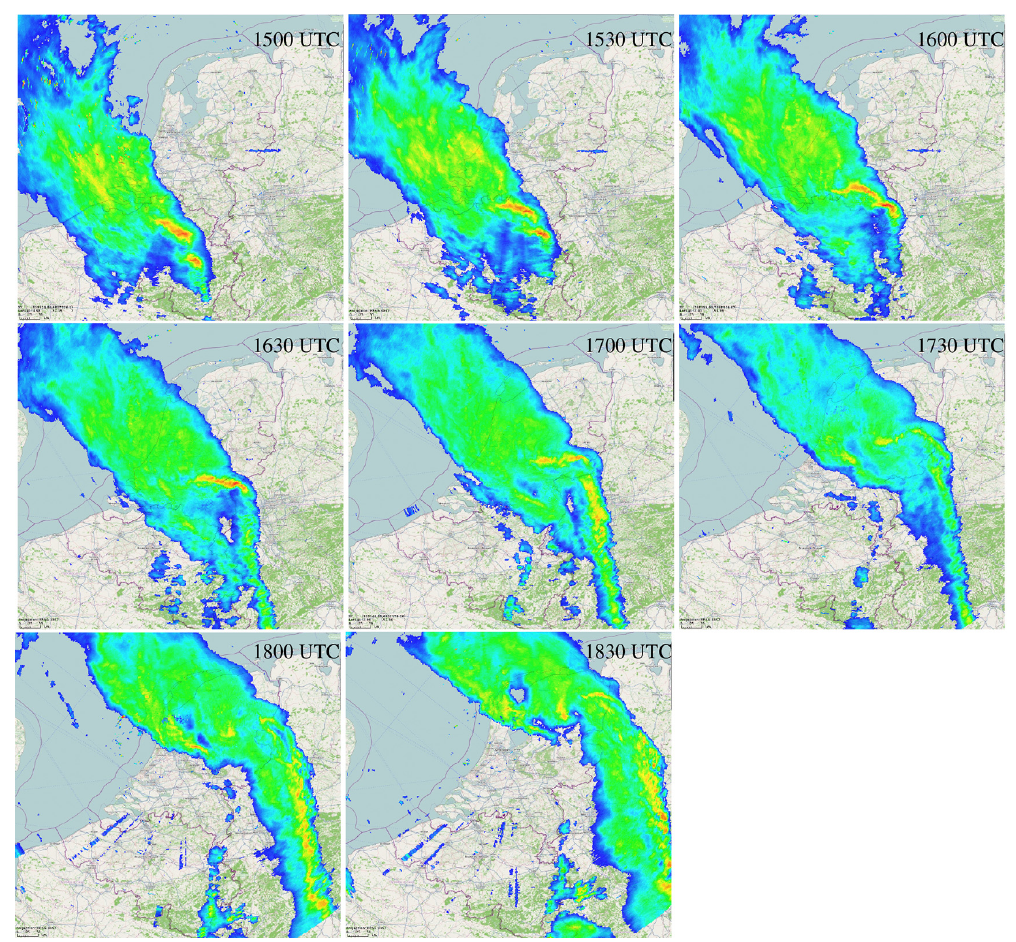
Figure 11. Rainfall intensity from radar images on 14 July 2010, from 15:00 to 18:30UTC. Red denotes precipitation intensity of over 30mmh − 1